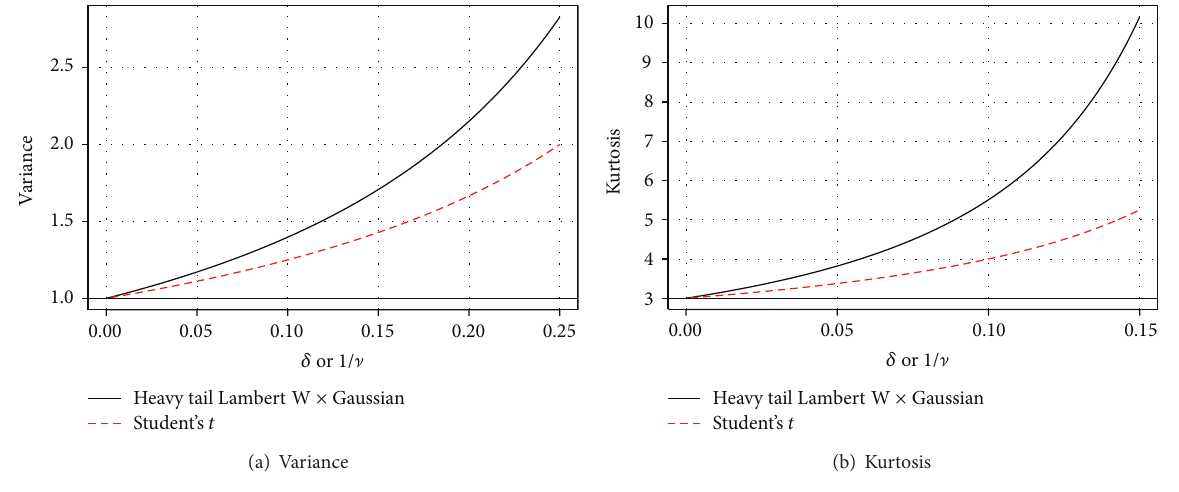
Figure 5: Comparing moments of Lambert W × Gaussian and Student’s 𝑡